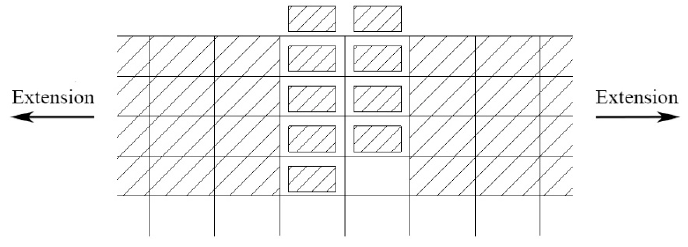
Figure 24. Hazard model of load distribution on steel storage racks without bracings.